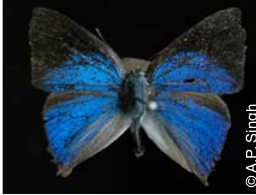
Image 44. Straightline Royal, Tajuria diaeus Female